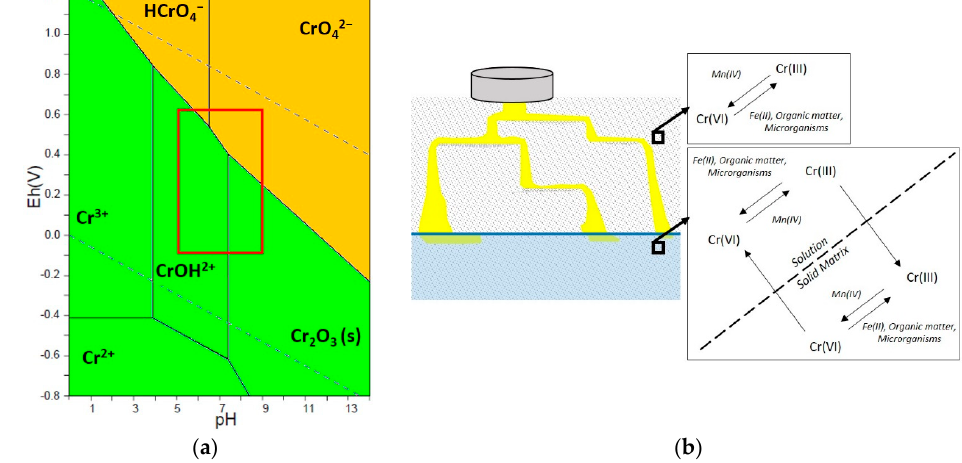
Figure 1. ( a ) Diagram of Pourbaix (redox potential Eh vs. SHE) for the chromium (in yellow Cr (VI) species, in green Cr (III) species); the red rectangle encloses the area of natural environmental conditions; ( b ) mechanisms of action on the chemical species of the chromium (in yellow) in the subsoil (in grey the unsaturated zone, in pale blue the saturated zone).